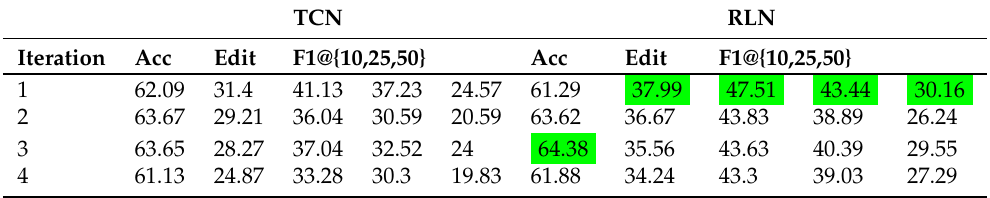
Table 11. RL-SSI in the Pancake context.